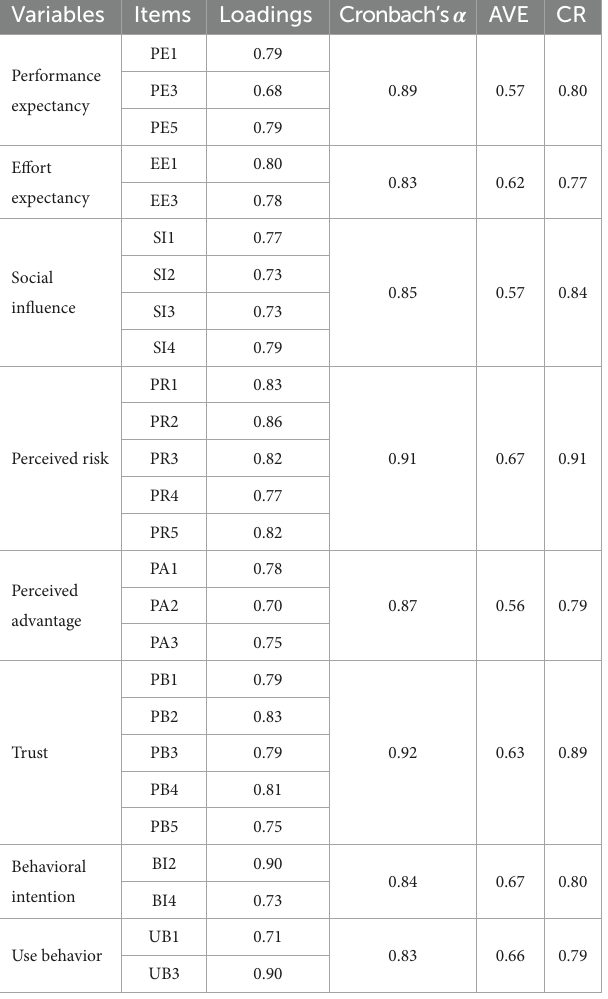
TABLE 1 Loadings and composite reliability.